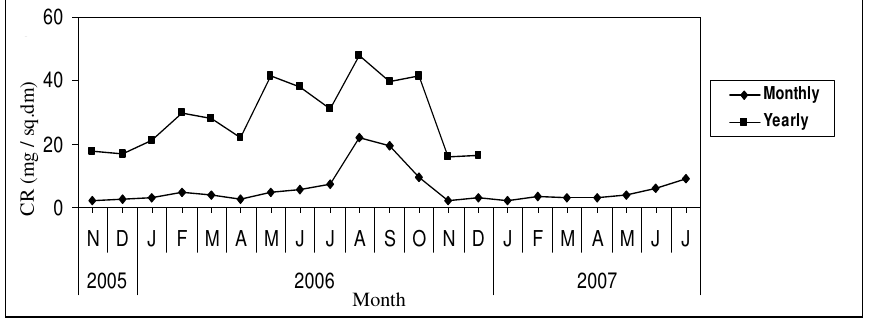
Figure 4 . Monthly and yearly corrosion rate (CR) of aluminium under outdoor exposure during different months at marine environment.